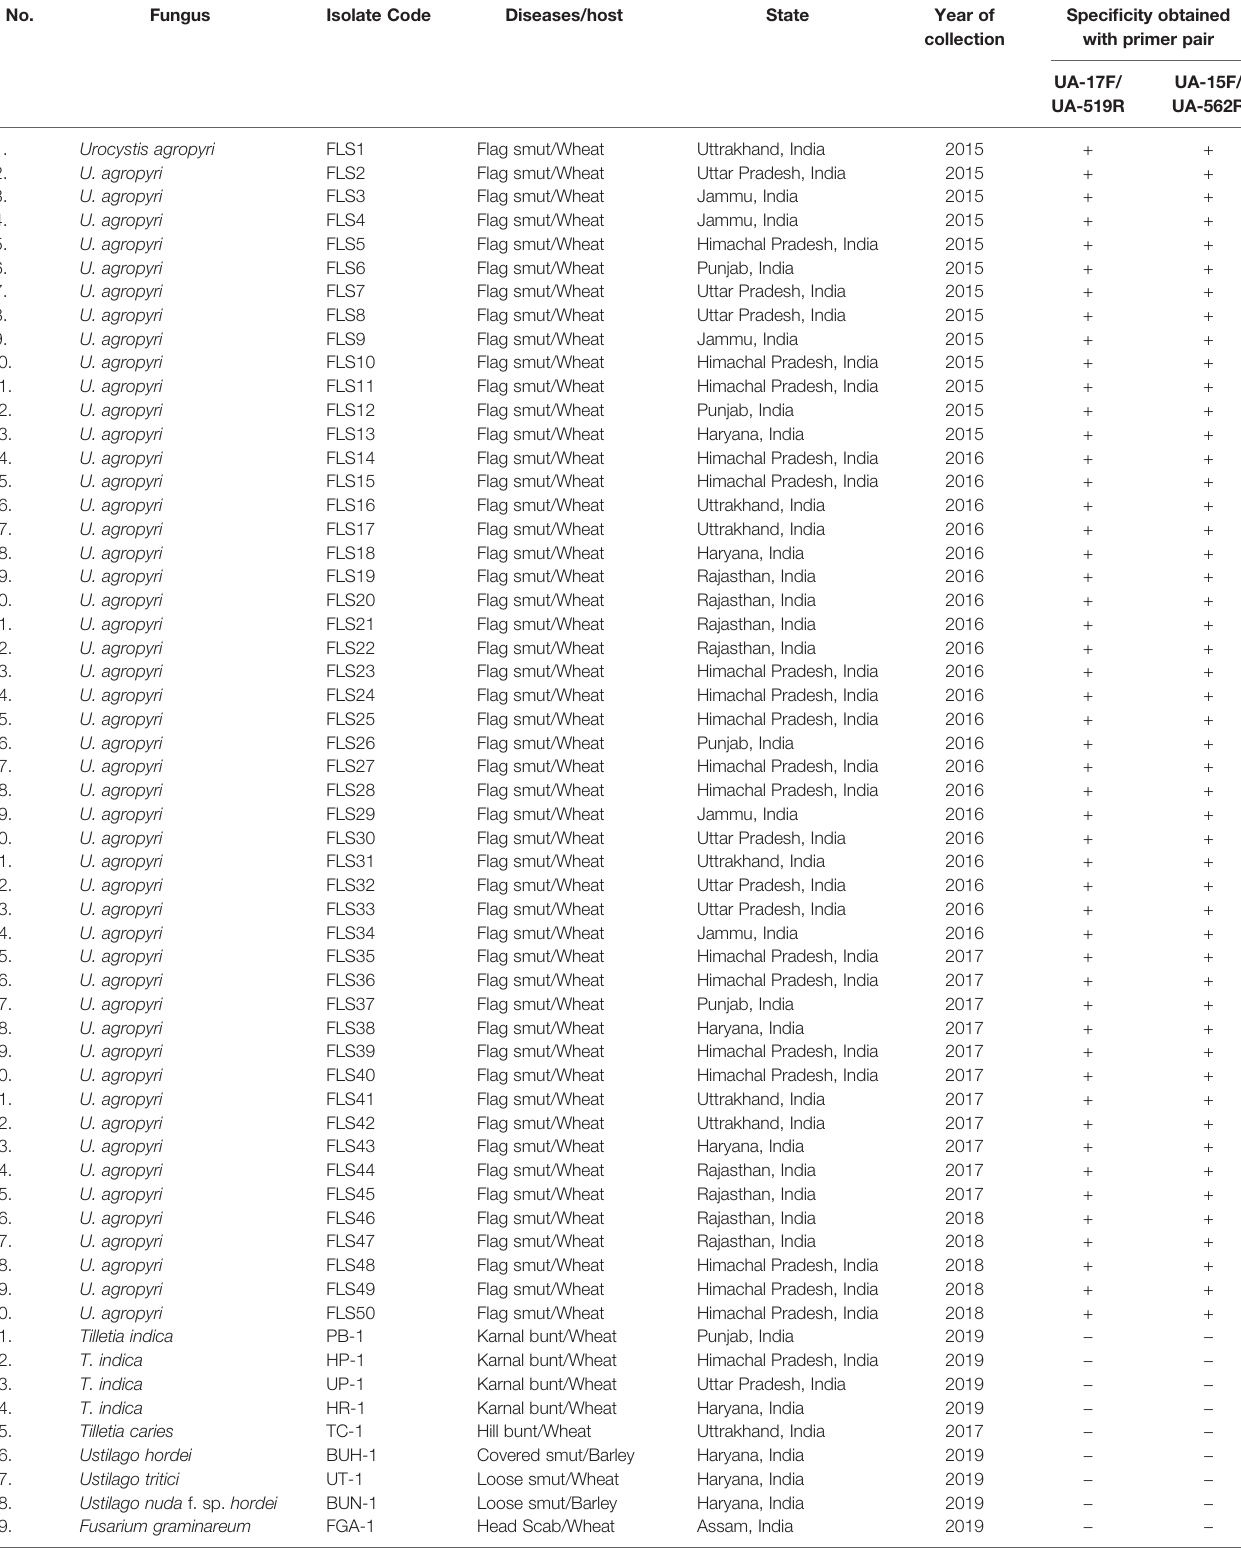
TABLE 1 | Fungal isolates used in the present study to evaluate primer speci fi city in PCR assays. S.